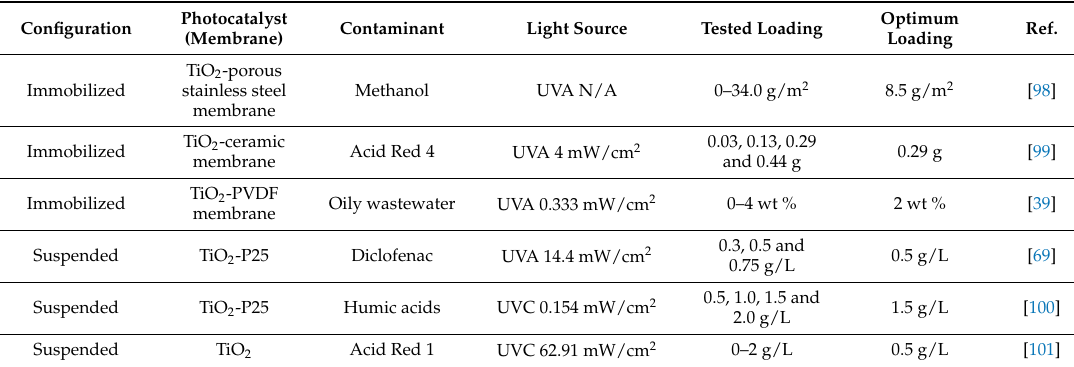
Table 3. The optimum photocatalyst loading in different PMR